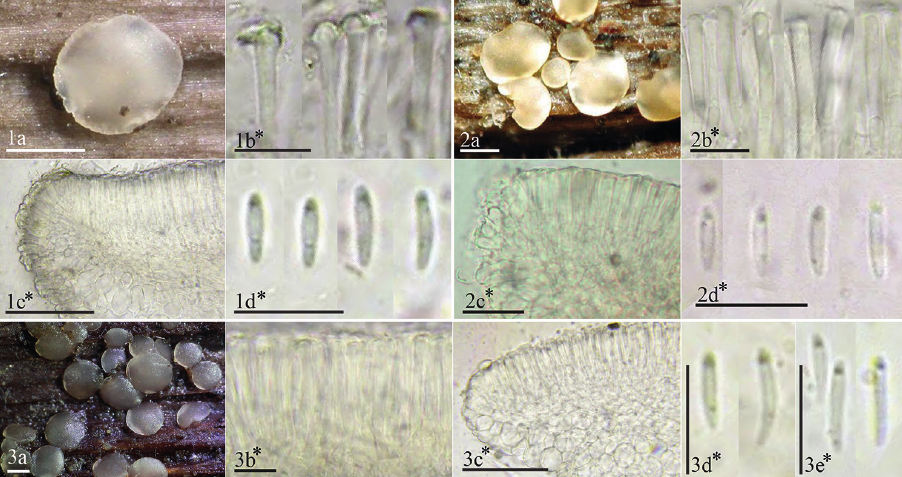
Figure 4. Morphological features of species related to Orbilia beltraniae . 1 Orbilia cardui 2 Orbilia co- toneastri 3 Orbilia rectispora . a Fresh apothecia b Paraphyses c Excipular tissues in median section d–e . Ascospores. Scale bars: 500 µm= 1a, 2a, 3a ; 50 µm= 1c, 3b ; 10 µm= 1b, d, 2b–d, 3c–e . All mounted in H2O. Photos: H.B. 7241a = 2a ; H.B. 9549 = 3b, d ; H.B. 9645b = 2b, d ; H.B. 9891 = 1a, c–d ;